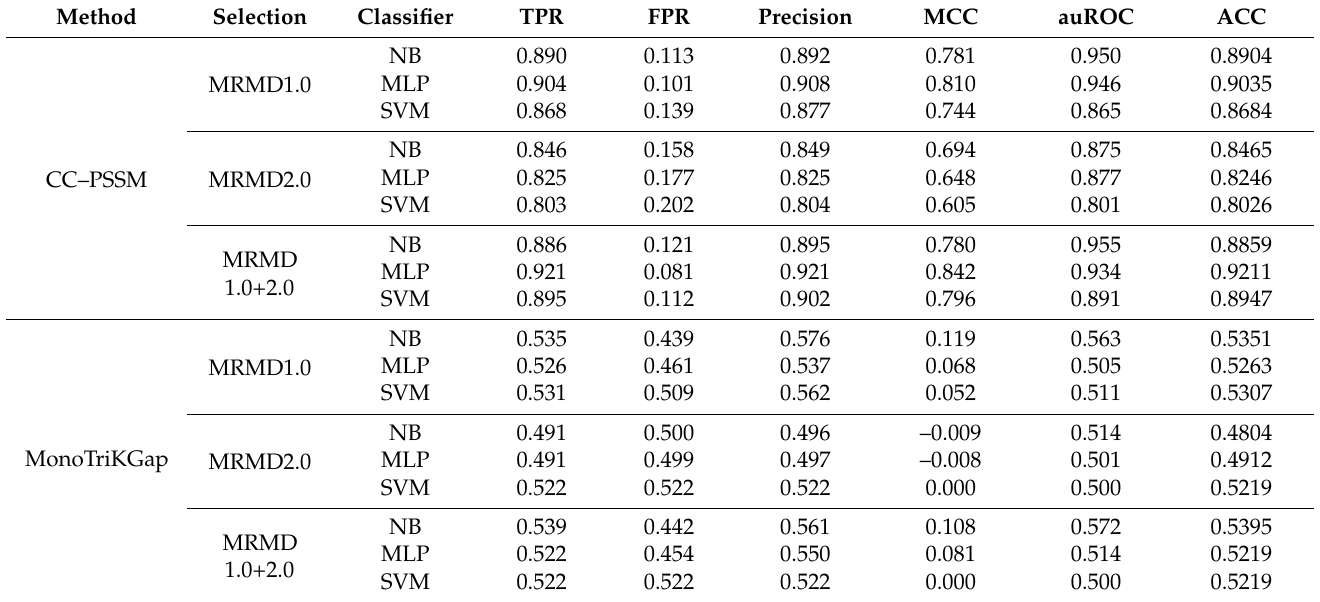
Table 4. Classification results of different two–dimensional key feature recognition